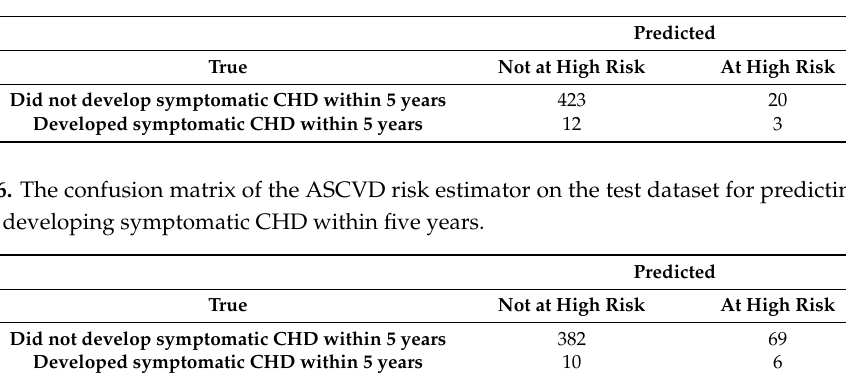
Table 5. The confusion matrix of the Framingham risk score on the test dataset for predicting a high risk of developing symptomatic CHD within five years.